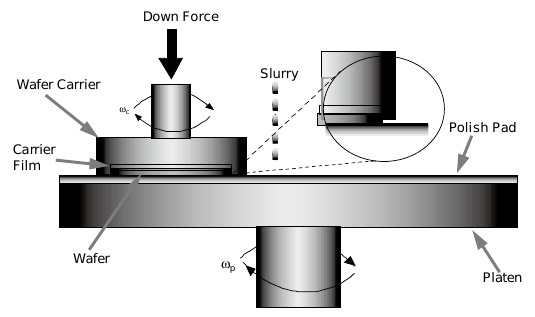
Fig.1 Schematic diagram of a CMP